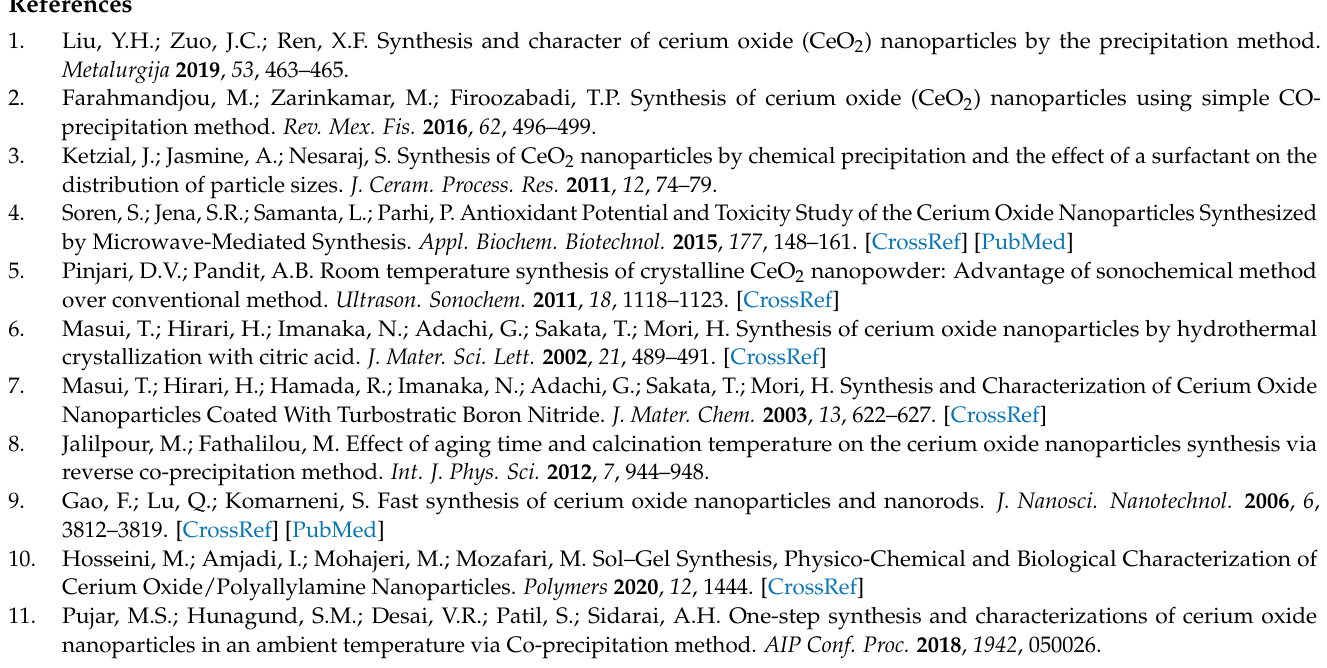
Figure S2: TEM images of nanoceria-containing composites of CMC with 7.1 wt.% Ce4+ (a); 9.0